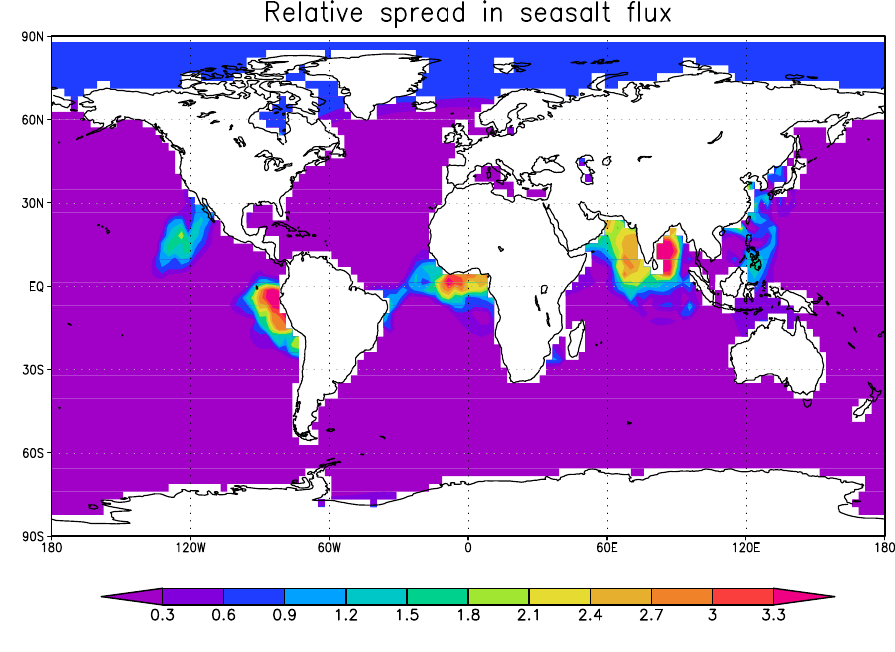
Figure 10. Relative spread in newly estimated sea salt emissions, averaged over the last three weeks of January